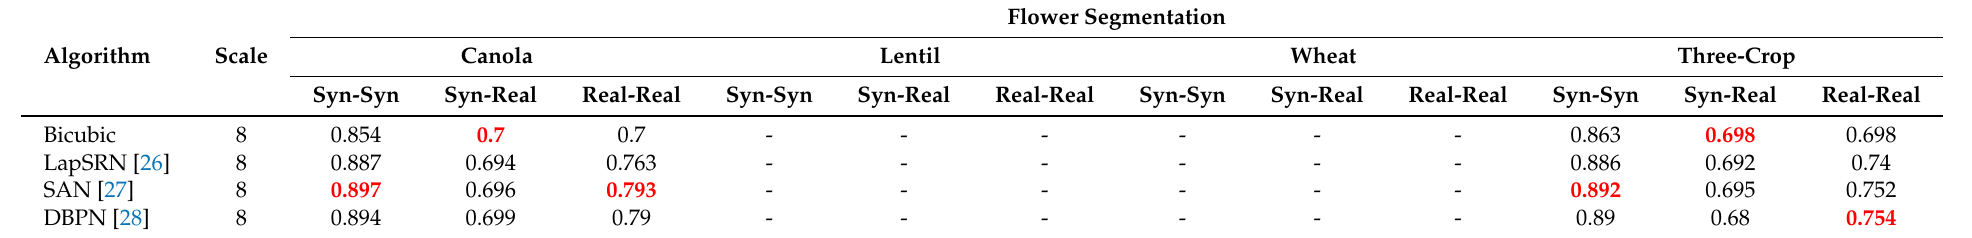
Table 5. Average flower segmentation DSC value for 8 are indicated in red